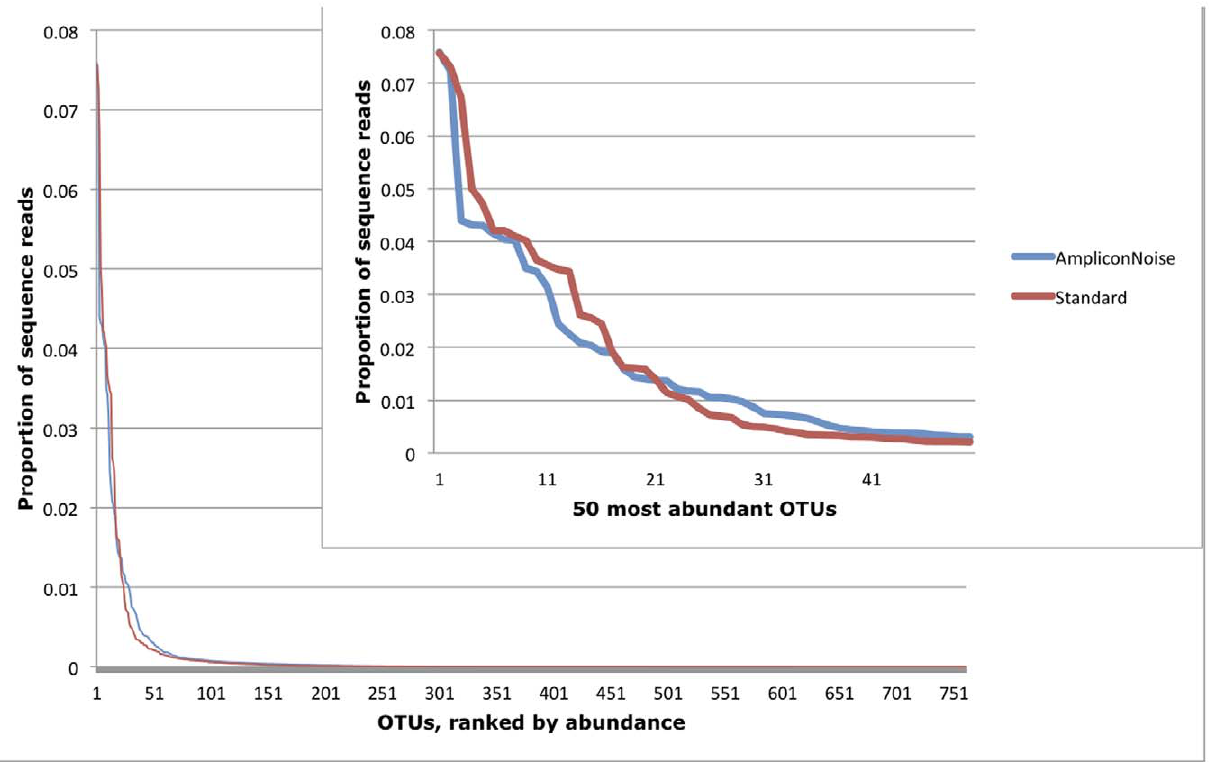
Figure 2. Impacts of de-noising on the rank-abundance distribution of OTUs. AmpliconNoise processing significantly altered the OTU rank- abundance distribution (two-sample Kolmogorov-Smirnov test; D=0.20, p , 0.0001), and increased evenness.